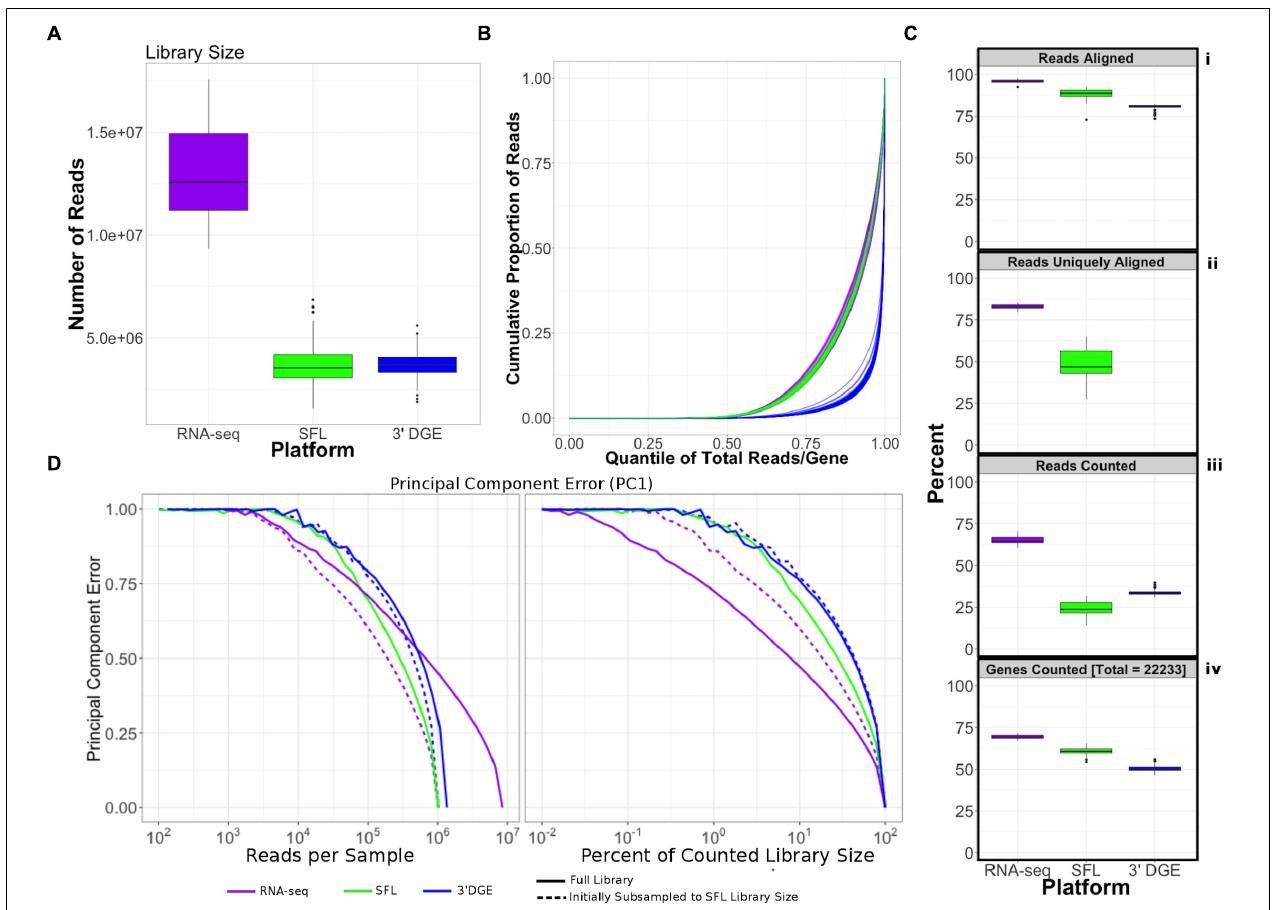
FIGURE 2 | Comparison of coverage between poly-A RNA-seq, SFL, and 3 (cid:48) DGE. (A) Boxplots of distribution of library size for each platform. (B) Cumulative distribution of reads assigned to individual genes per sample. The x -axis indicates the quantile for each gene in terms of ranking by relative expression. The y -axis shows the cumulative proportion of total counted reads assigned to these genes, i.e., the running sum of reads divided by the total number of reads across all genes. (C) The top 3 boxplots show the percentage of reads aligned (i) , uniquely aligned (ii) , and counted (iii) relative to the total library size for each platform. The bottom boxplot (iv) shows the proportion of genes with counts > 1, for protein-coding genes annotated across all 3 platforms (18,488). For (ii) , “Reads Uniquely Aligned” is not shown for 3 (cid:48) DGE because “Reads Uniquely Aligned” and “Reads Counted” are the same values as a result of the data pre-processing protocol, specific to 3 (cid:48) DGE (see section “Materials and Methods”). Counts values for these percentages are given in Supplementary Figure S1A . (D) Analysis of the principal component error of subsampled counted library sizes for full coverage poly-A RNA-seq, SFL, and 3 (cid:48) DGE for principal component 1. Results for principal component 2–5 is shown in Supplementary Figure S1D . Initial subsamples of Poly-A RNA-seq and 3 (cid:48) DGE to the SFL library size are also given as dotted